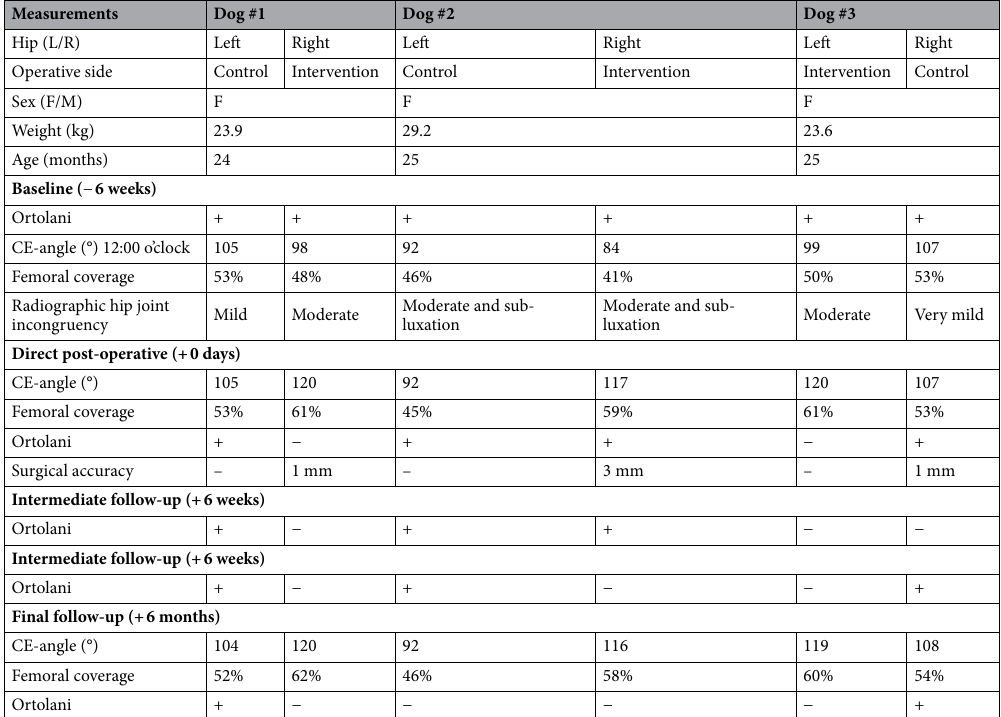
Table 2. Baseline and postoperative measurements (radiology and Ortolani test). L left, R right, F female, M male, CE center edge